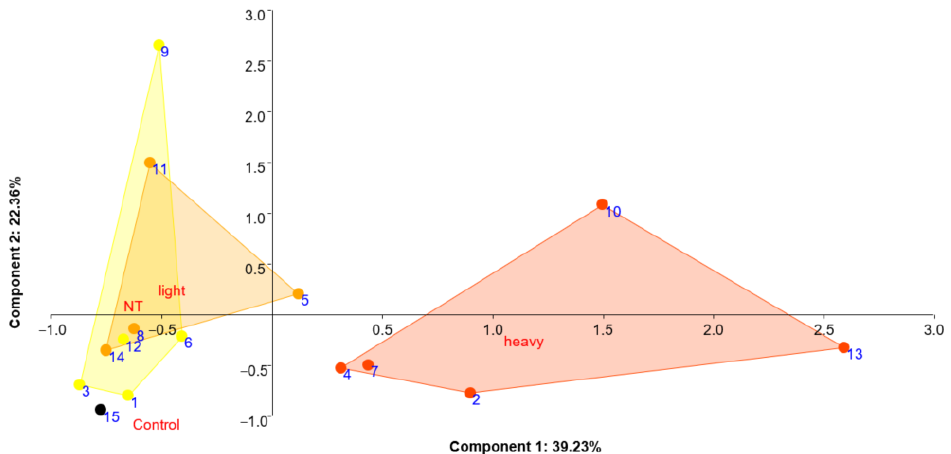
Figure 2. PCA score plot representing spirits aged with different alternative products. Results of GC-MS analysis for xylovolatile compounds. The graph highlights the effect of toasting on spirit composition. Yellow, NT, non-toasted wood; red, heavy toasting; orange, light toasting.